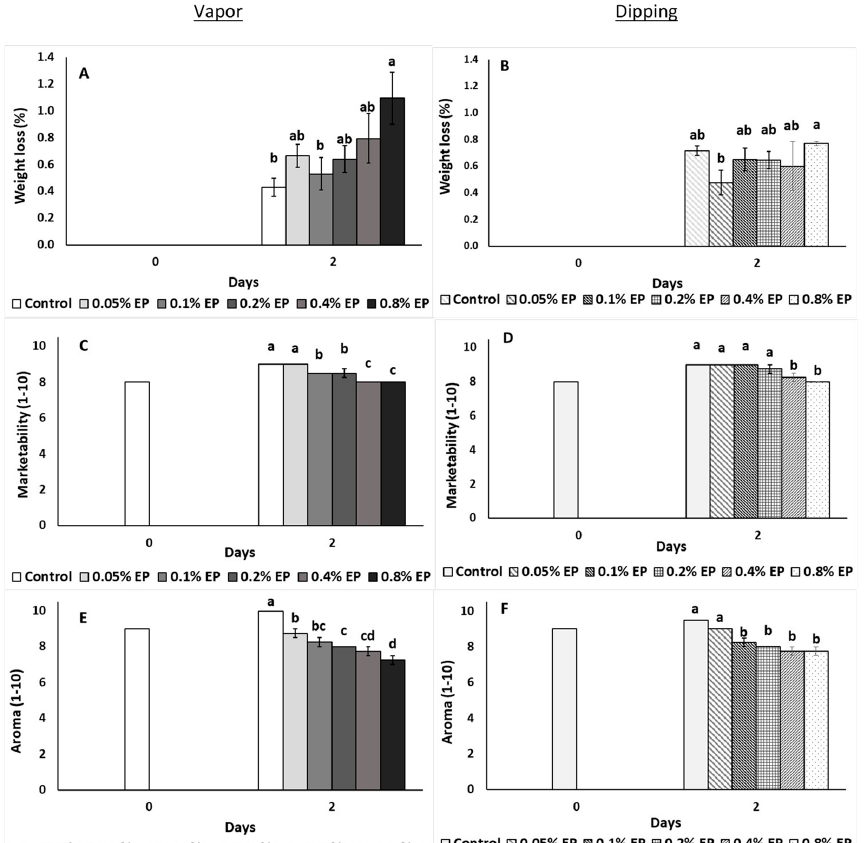
Figure 1. Effects of vapor ( A , C , E ) or dipping ( B , D , F ) application with eco-product (EP) at different concentration (0%-0.05%-0.1%-0.2%-0.4% and 0.8%) or control (application with water) on weight loss (%), marketability (scale 1–10) and aroma (scale 1–10) of cucumber fruits stored at 11 ◦ C and RH ~90%. Means